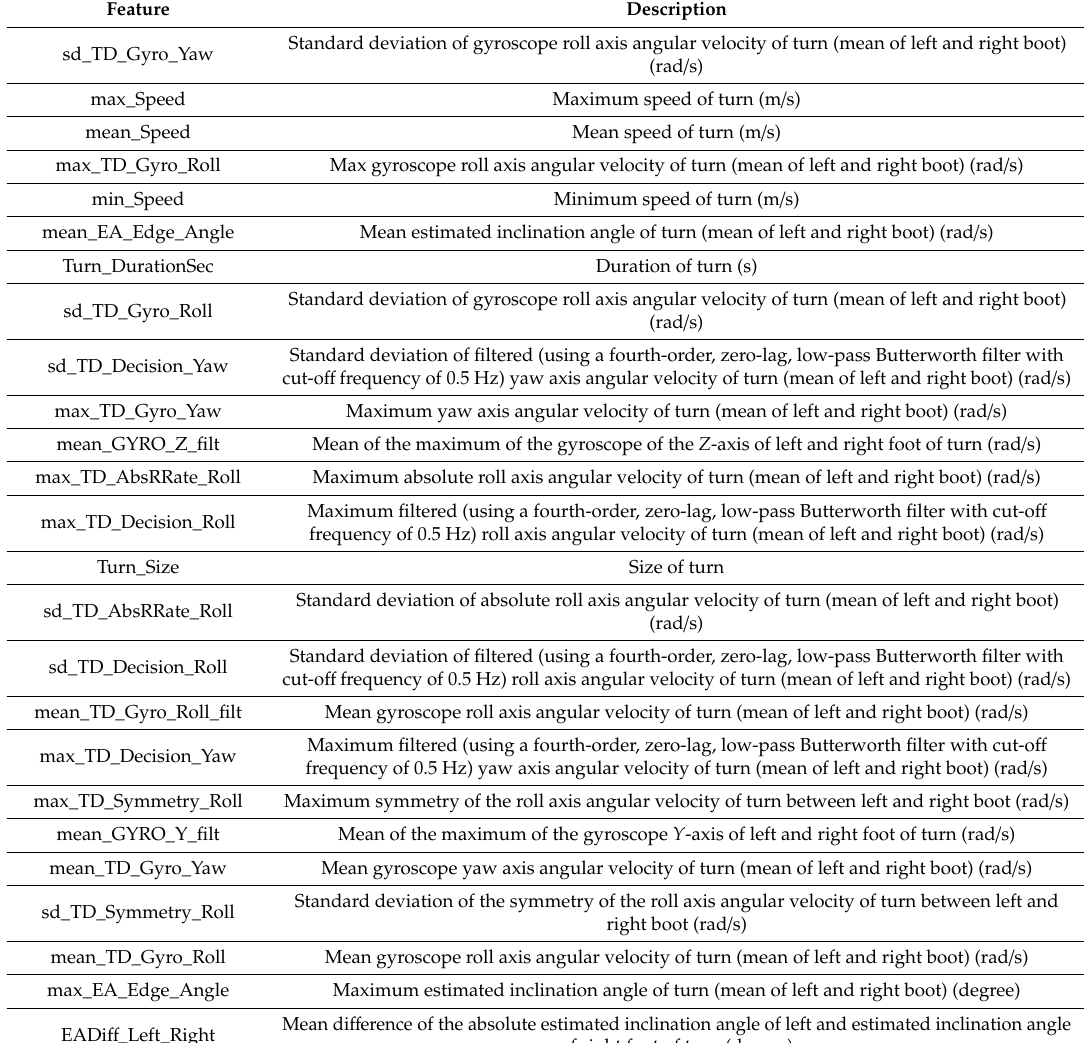
Tables A2 and A3 list the features used for alpine skiing style classification. Table A2 contains the used features for the prediction of drifted and carved turns based on recursive feature elimination. Table A3 lists the features for the prediction of the snowplow-steered and snowplow turns. Table A2. List of features for drifted and carved turn